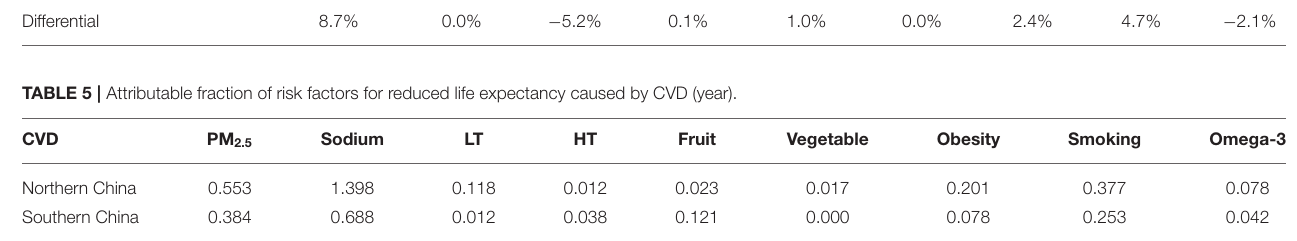
TABLE 4 | Attributable fraction of risk factors for cerebrovascular disease in northern and southern China. Sodium Vegetable Northern China (% and 95%CI) Southern China (% and 95%CI)